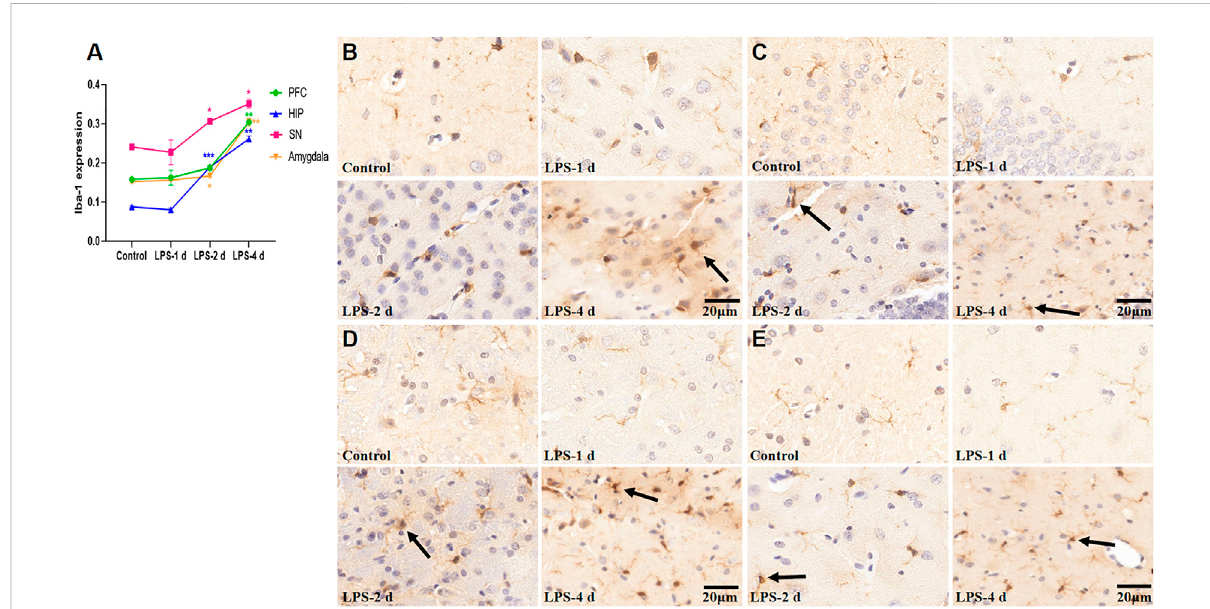
FIGURE 9 Ionizedcalcium-bindingadaptermolecule(Iba-1)expressioninthePFC,HIP,SN,andamygdalaforallgroups( n =3). (A) TheAODvalueofeach groupwas compared.Data are expressed as themean ±SEM.* p < 0.05, ** p < 0.01, *** p < 0.005, comparedtothecontrol group. (B) Representative photomicrographs of Iba-1 expression in the PFC (×400). (C) Representative photomicrographs of Iba-1 expression in the HIP (×400).